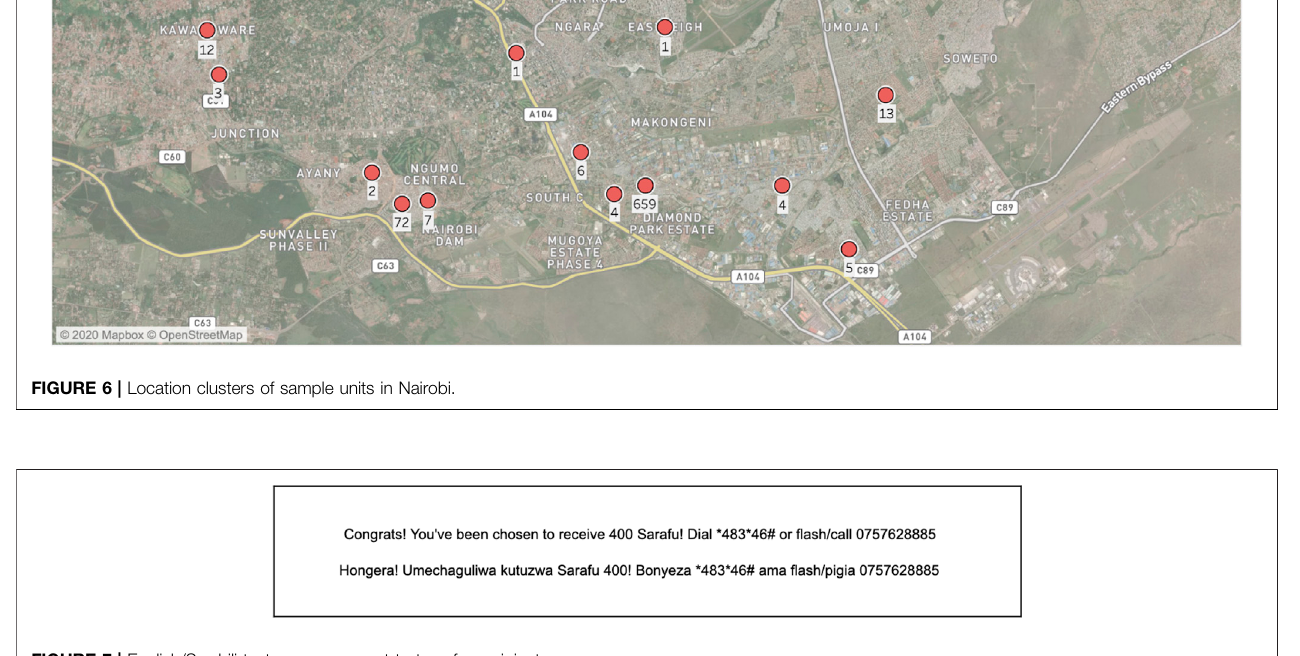
FIGURE 7 | English/Swahili text messages sent to transfer recipients.